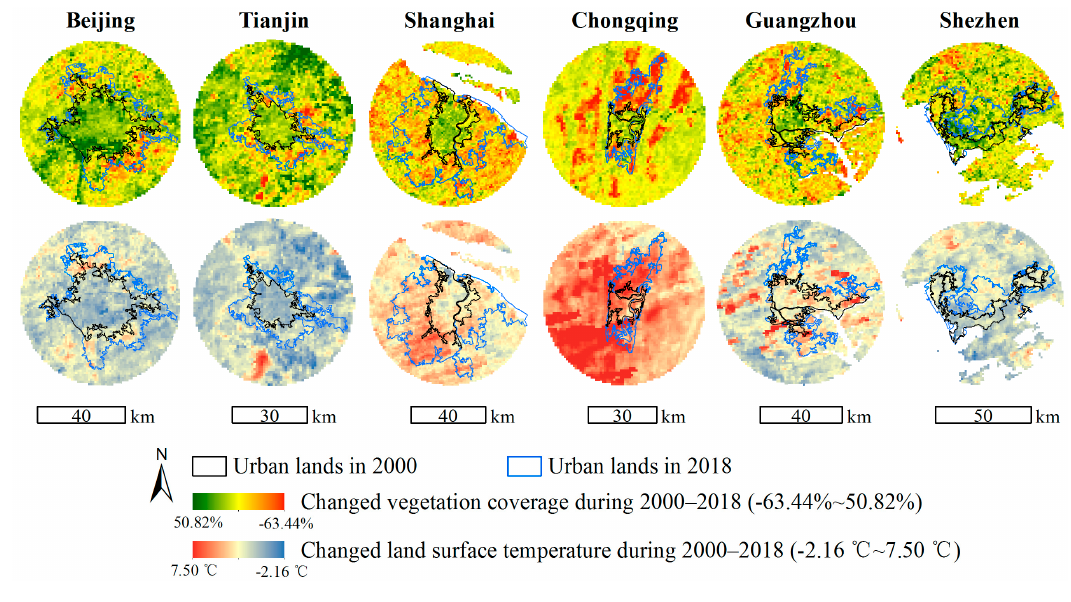
Figure 9. The dynamics of vegetation coverage and land surface temperature in China’s megacities during 2000–2018.